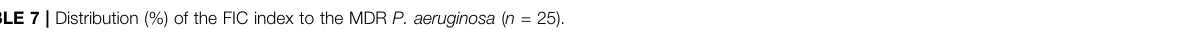
TABLE 7 | Distribution (%) of the FIC index to the MDR P. aeruginosa ( n = 25). Antibiotic (n)